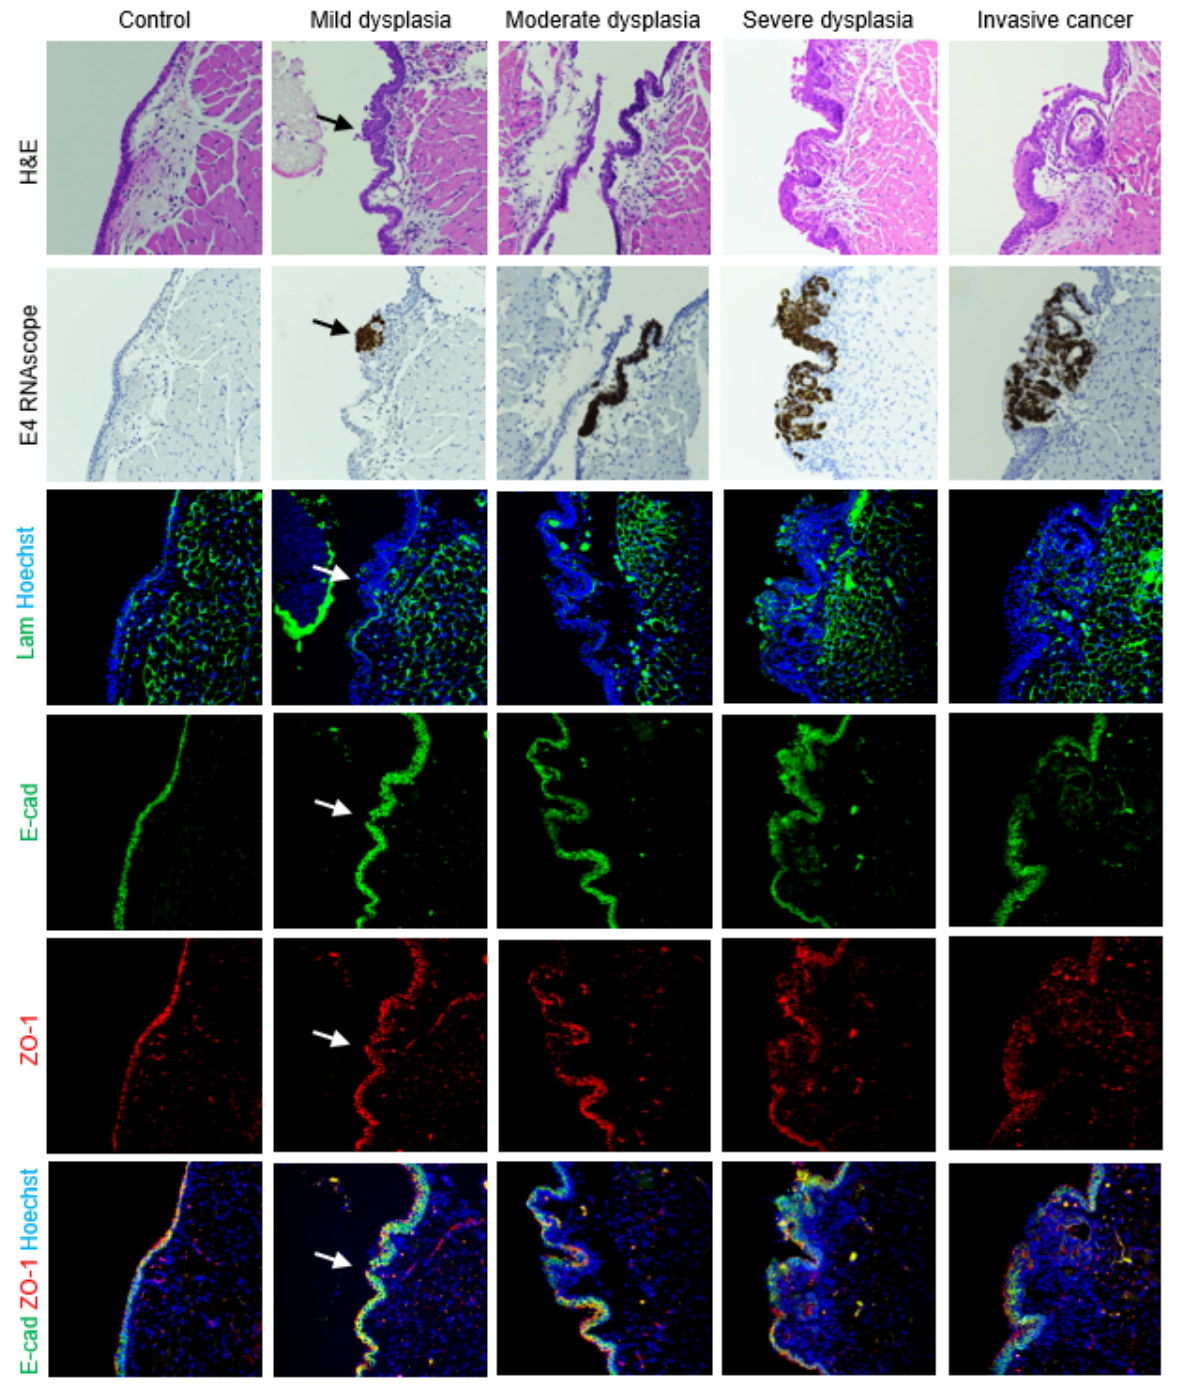
Figure 7. Perturbed epithelial barrier in vocal folds with disease induced by MmuPV1. Serial sections of control and diseased vocal folds stained with H&E, MmuPV1 E4 RNAscope ISH, costained laminin (green) and Hoechst (blue) IF, and costained E-cadherin (green), ZO-1 (red), and Hoechst (blue) IF shown both as separate channels and merged. 40× magnification. Arrows: MmuPV1-positive focal dysplasia with epithelial laminin and reduced E-cadherin and ZO-1. Some H&E and RNAscope images reproduced with permission from our companion paper [3].